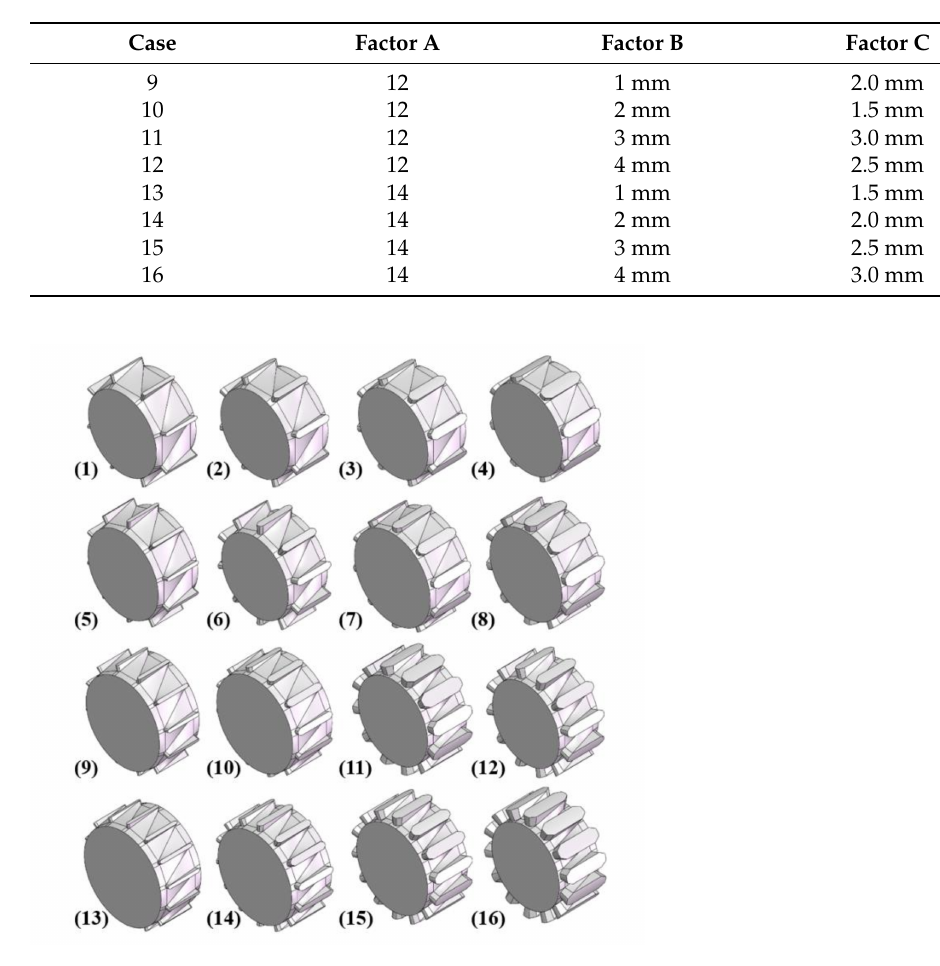
Figure 4. The torsion configurations in each test group among the total 16 groups.